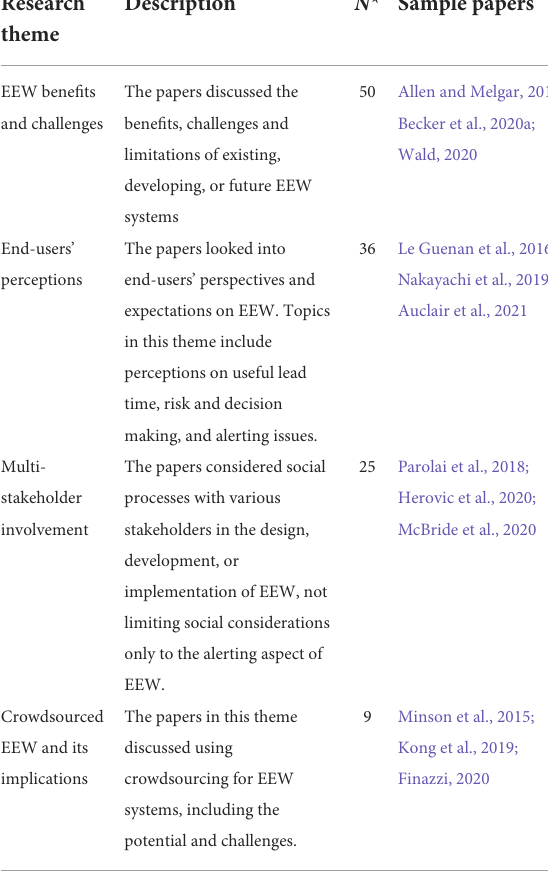
TABLE 3 Summary of benefits discussed by the articles on having an EEW system through the disaster management